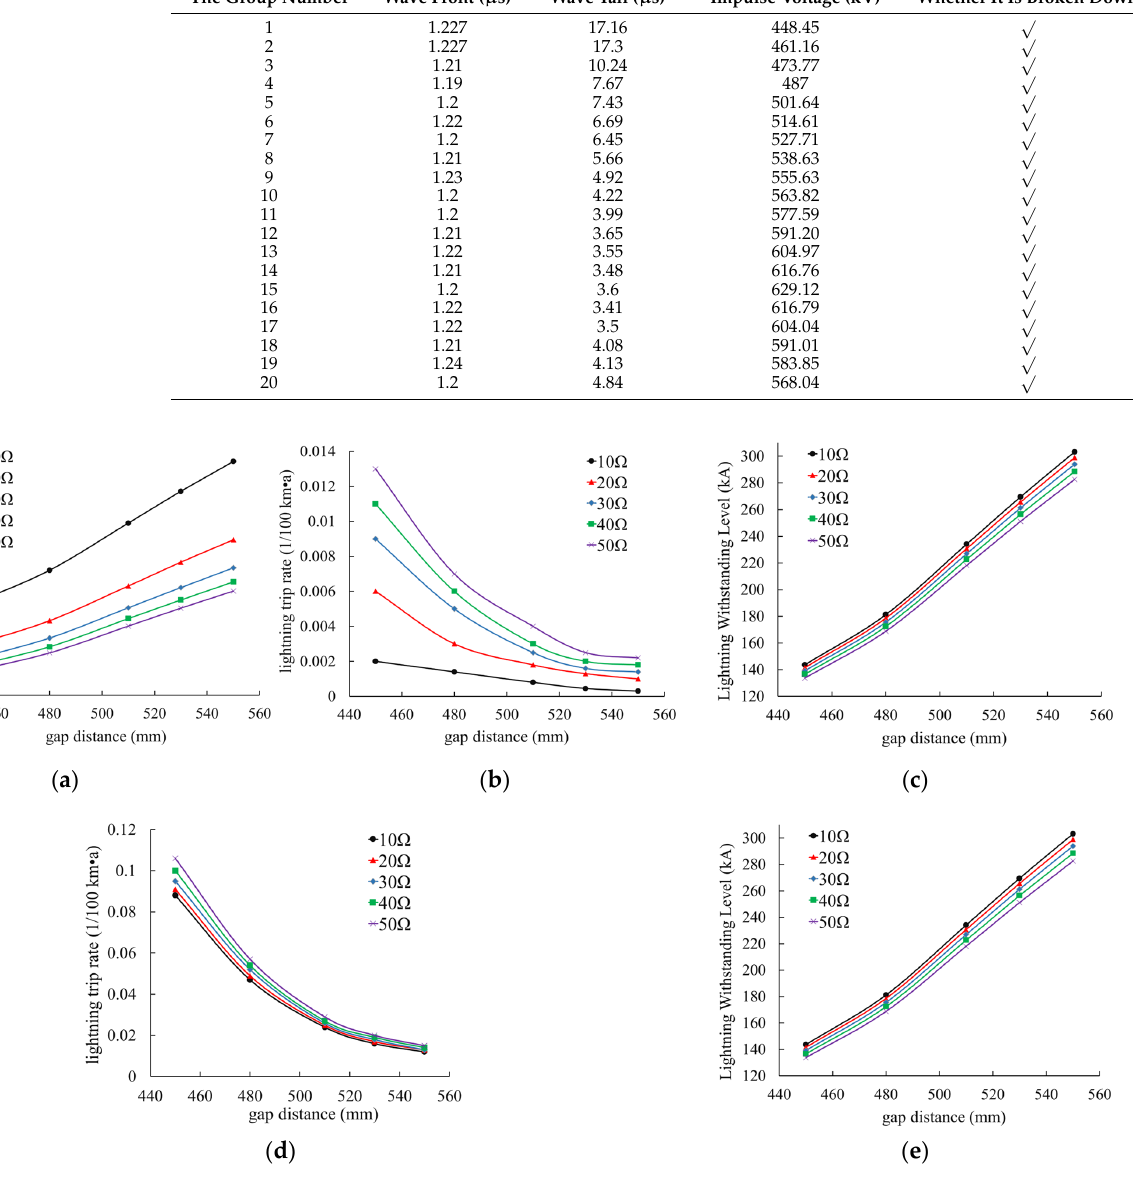
Figure 9. Lightning protection performance under different gap distances: ( a ) trend chart of back flashover LWL; ( b ) trend chart of back flashover lightning trip rate; ( c ) trend chart of direct LWL; ( d ) trend chart of direct lightning trip rate; ( e ) trend chart of direct lightning trip rate.